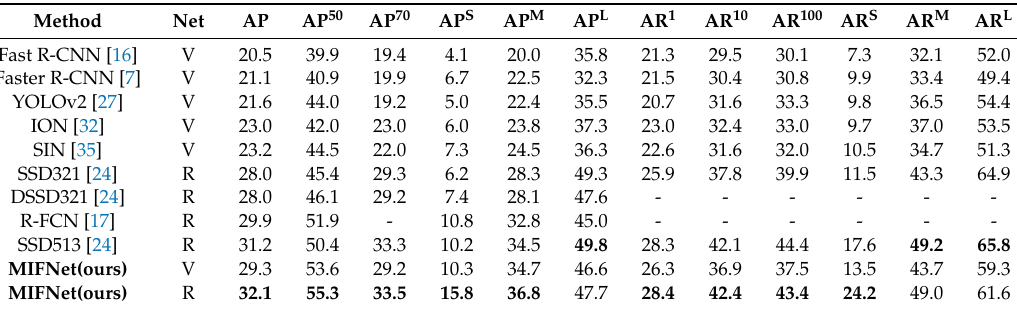
Table 4. Detection results on MS COCO 2014 minival. Train set: trainval35k: MS COCO train + 35k val. “V” and “R” denote the model uses VGG-16 and Resnet-101 as backbone networks, respectively. The bold characters represent the best result for each column.